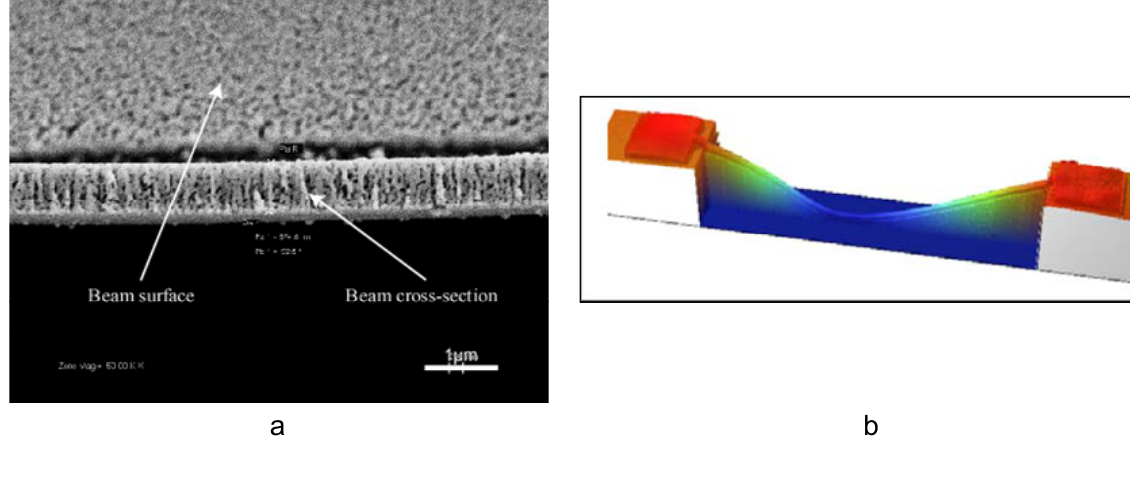
Figure 12. (a) FIB-prepared beam cross-section for thickness measurement. (b) A typical interferometric image of the buckled beam shape following rapid thermal treatment of freestanding Au-Ag